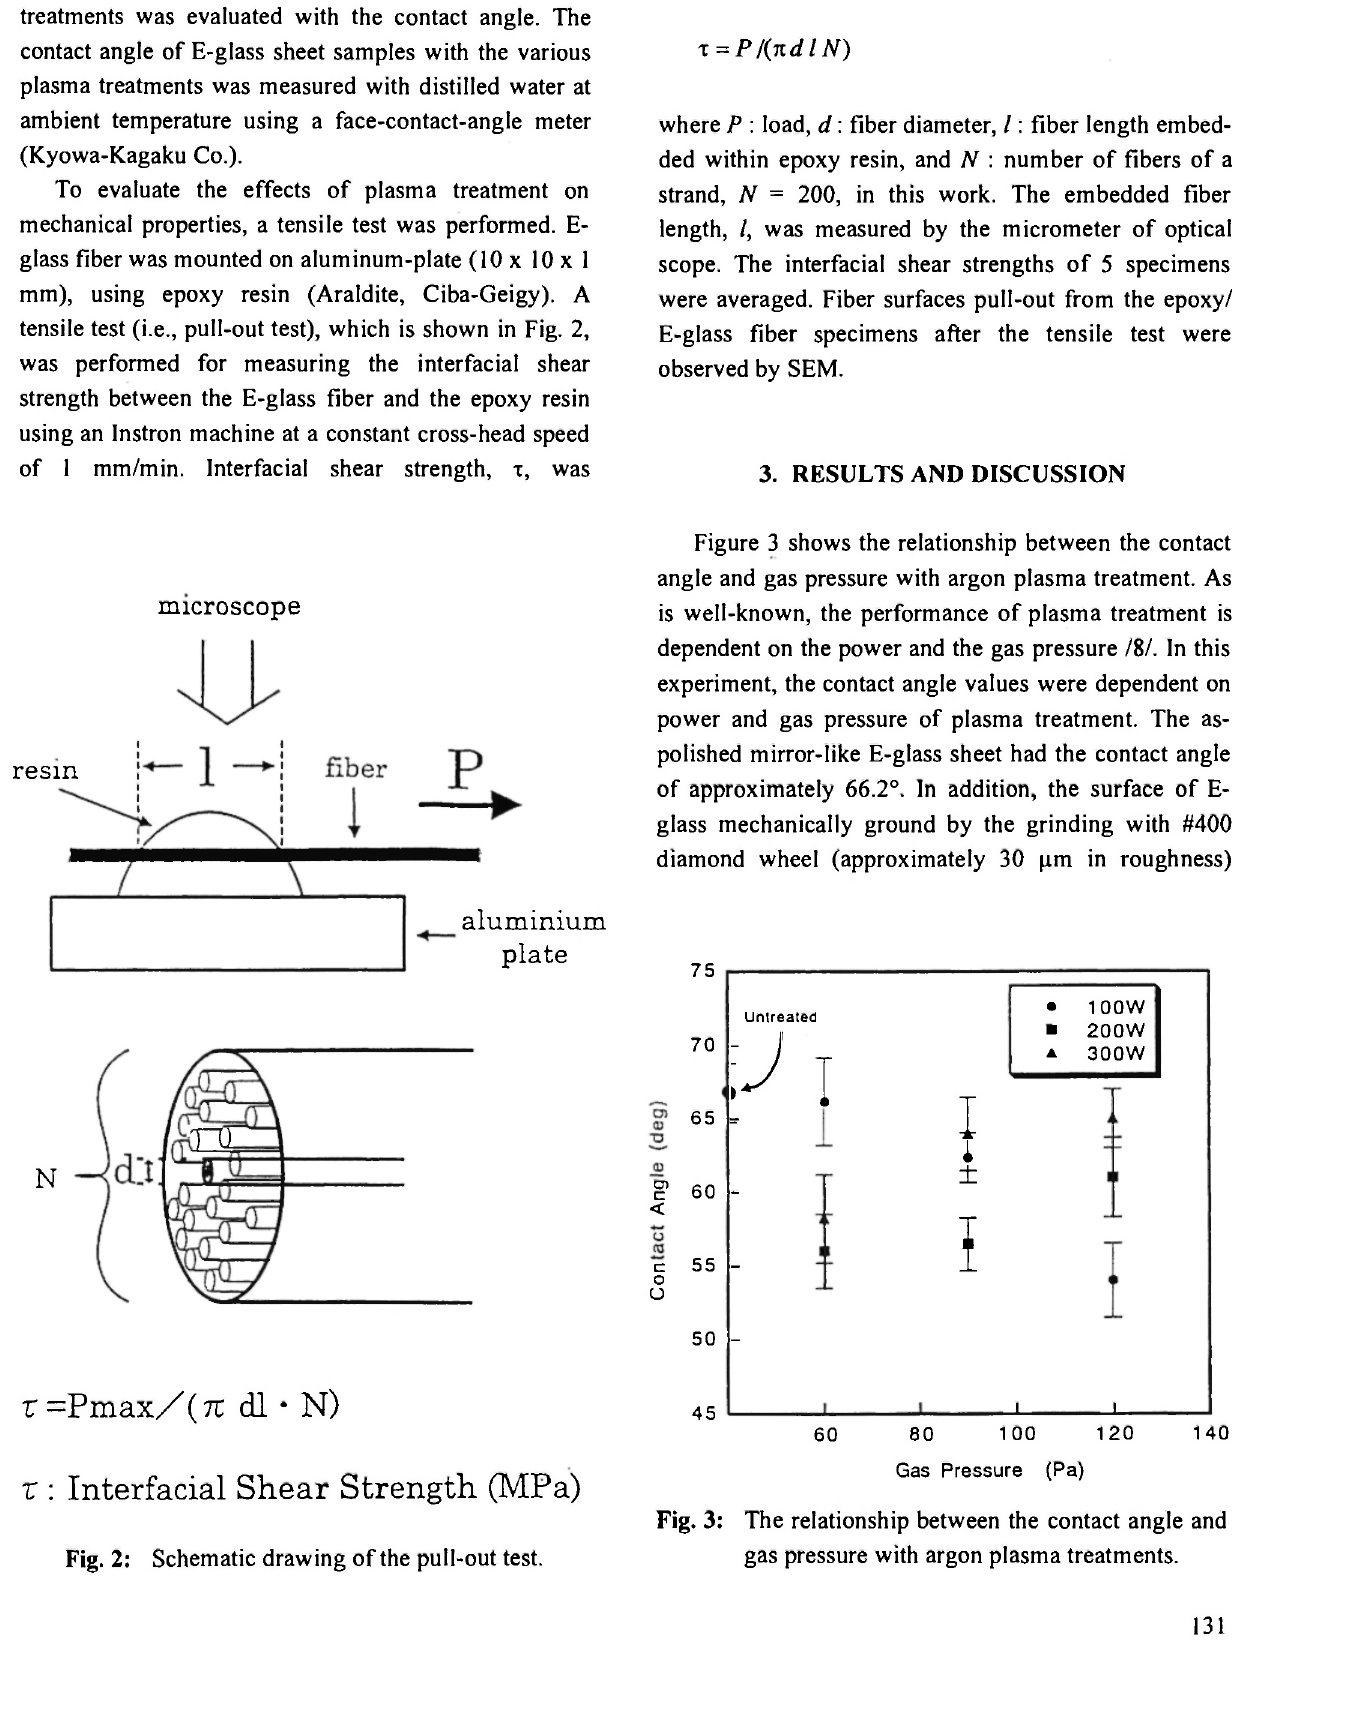
Fig. 3: The relationship between the contact angle and gas pressure with argon plasma